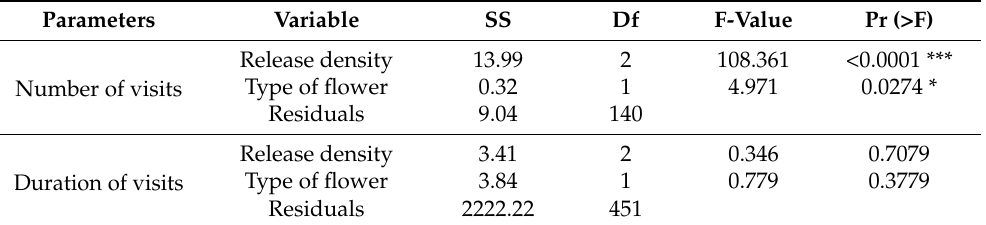
Table 1. Generalized linear models (deviance analysis, type III) for the number and duration of the visits recorded on watermelon triploid flowers. The independent variables were release density (15, 30 and 45 individuals/m 2 ) and flower type (staminate versus pistillate).